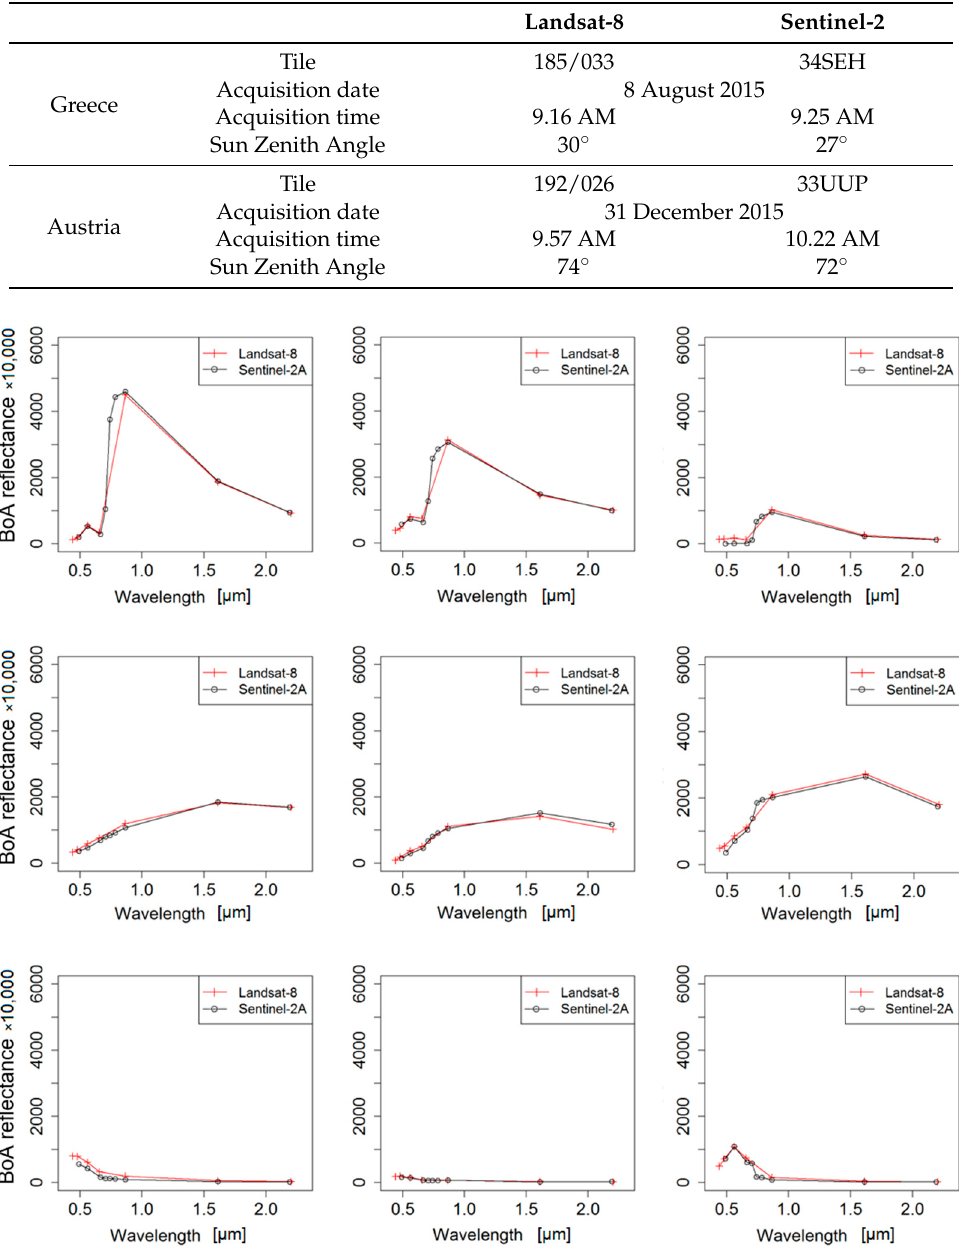
Figure 5. Examples of comparison between BoA Landsat-8 and Sentinel-2 reflectance for randomly-selected points (including vegetation, soil and water). The images were acquired on the same day. The reflectance from Sentinel-2 at 10 m spatial resolution was averaged within a buffer of 30 m to match the pixel size of Landsat-8. BoA reflectance values are scaled by 10,000.